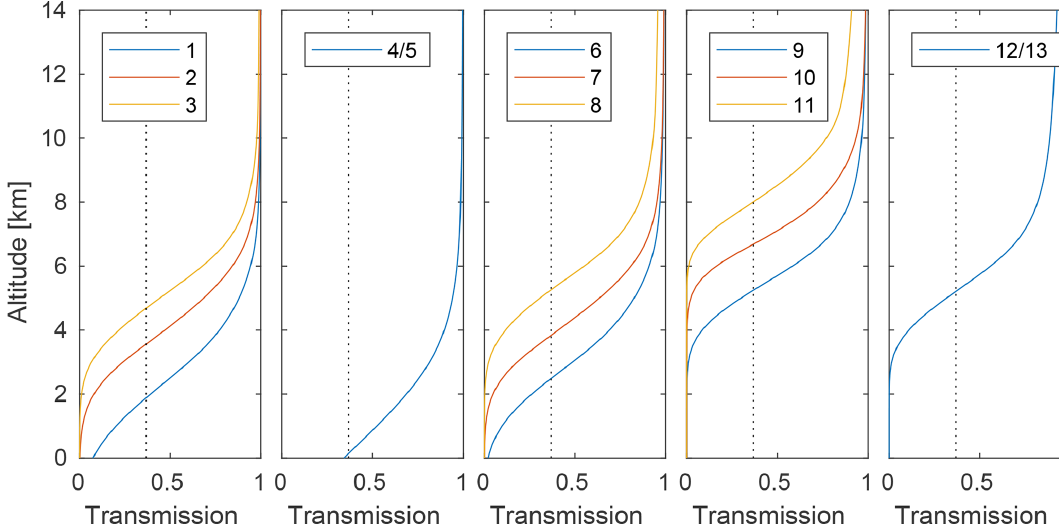
Figure 4. Channel mean transmission between altitudes in the atmosphere and ICI, according to a mid-latitude winter scenario. The dotted line corresponds to an optical thickness of 1.